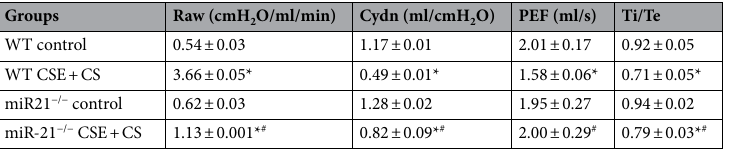
Table 4. Comparison of lung function in different groups of mice. Data are expressed as median and range. *P < 0.05 versus control group, # P < 0.05 versus WT CSE + CS group (n = 5).